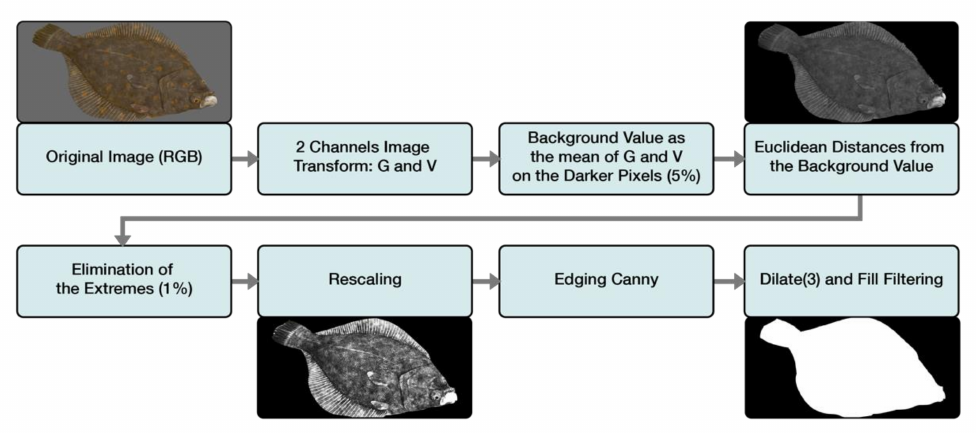
Figure 11. Flow chart to sort fish in MATLAB